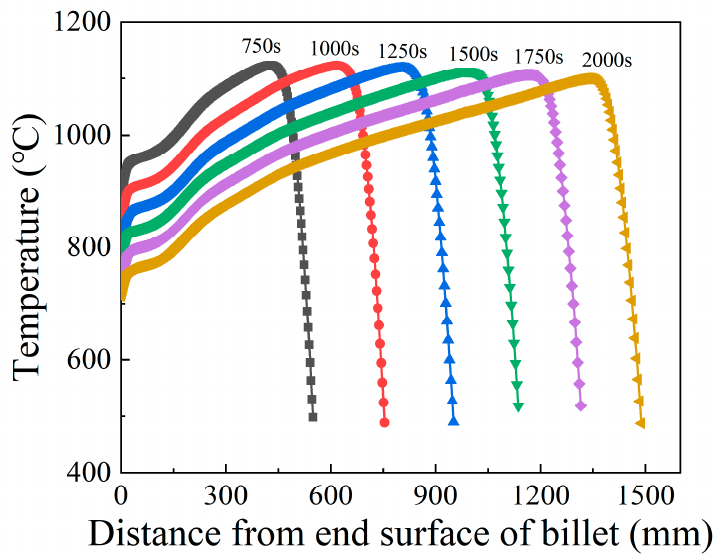
Figure 20. Temperature distributions on the central axis of the billet corresponding to diverse electric upsetting moments.